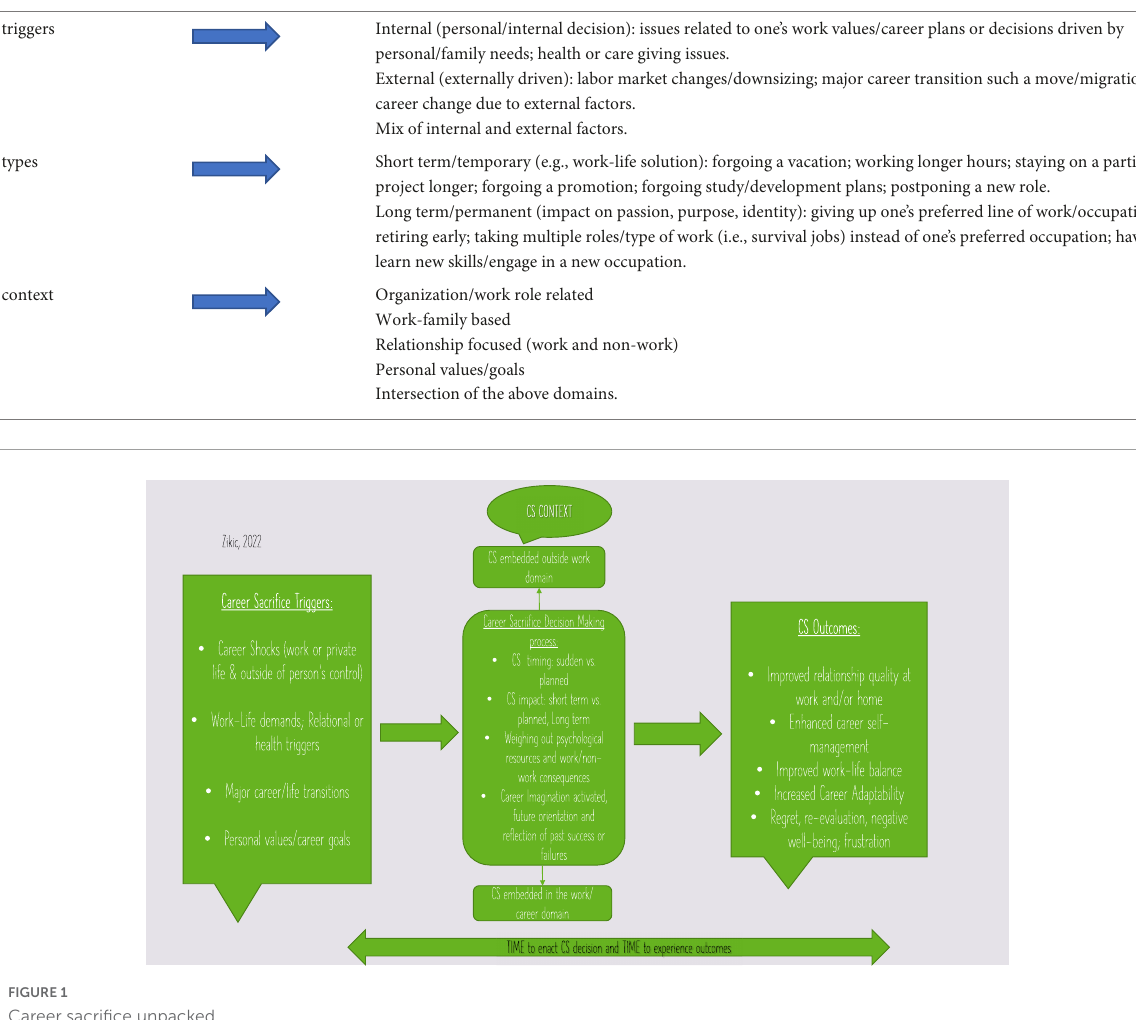
TABLE 1 Career sacrifice: Triggers, types and context.